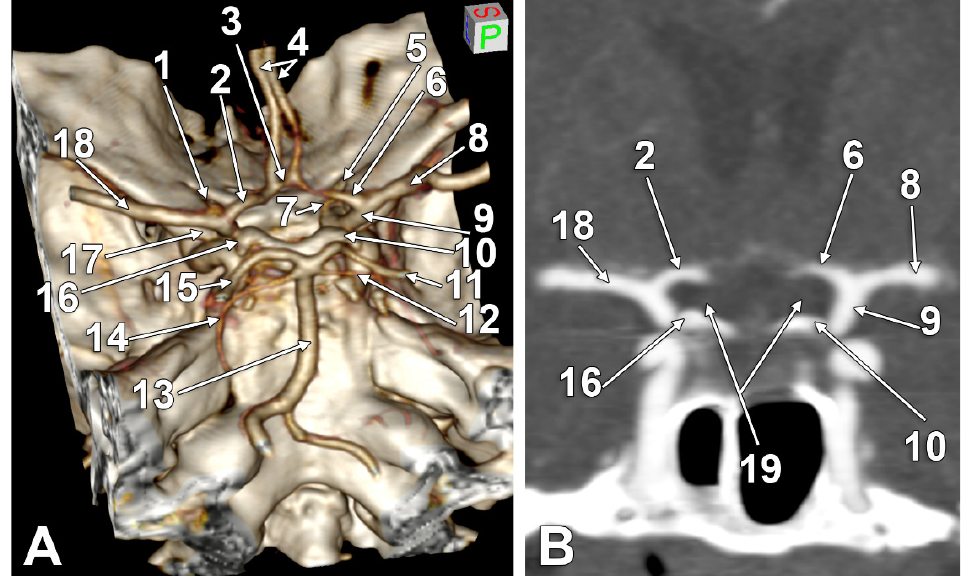
Figure 1. ( A ) Three-dimensional volume rendering of the skull base, left posterosuperolateral view. ( B ) Coronal cut through the internal carotid arteries bifurcation. Supraoptic A1 segments of the anterior cerebral arteries. 1. Left optic canal; 2. supraoptic A1 segment of the left anterior cerebral artery; 3. anterior communicating artery; 4. A2 (postcommunicating) segments of the anterior cerebral arteries; 5. right optic canal; 6. supraoptic A1 segment of the right anterior cerebral artery; 7. right ophthalmic artery; 8. right middle cerebral artery; 9. right internal carotid artery; 10. right posterior clinoid process; 11. right posterior cerebral artery; 12. right superior cerebellar artery; 13. basilar artery; 14. left superior cerebellar artery; 15. left posterior cerebral artery; 16. left posterior clinoid process; 17. left anterior clinoid process; 18. left middle cerebral artery; 19. optic nerves.